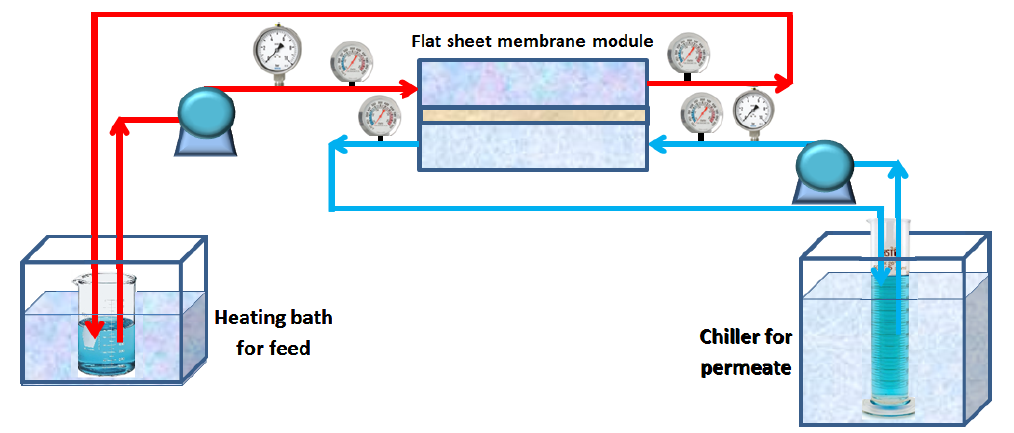
Figure 3. Schematic diagram of the experimental rig of the DCMD process.